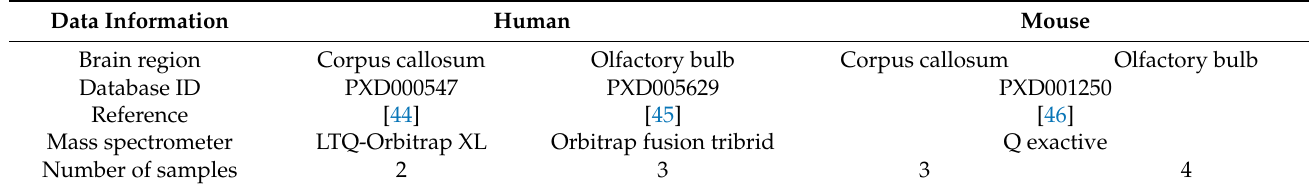
Table 1. Mass spectrometry data